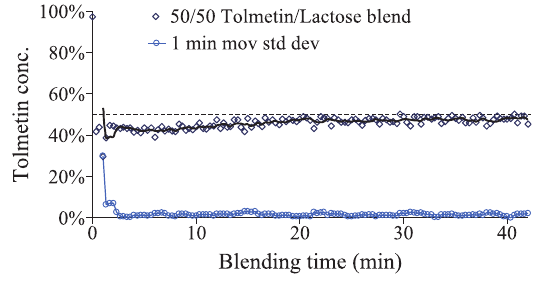
Fig. 1 Ideal powder mixing. Near IR monitoring of the com- position of a 50:50 lactose-tolmetin mixture as a func- tion of blending time. Reprinted with permission from Ref. (Ely D. et al., 2006). Copyright: (2006) Elsevier